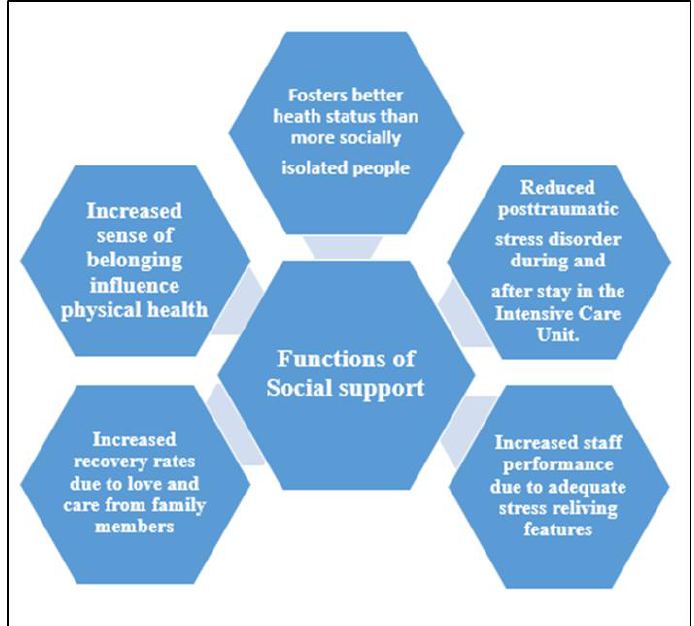
Figure 2. Schematic summary of the advantages of social